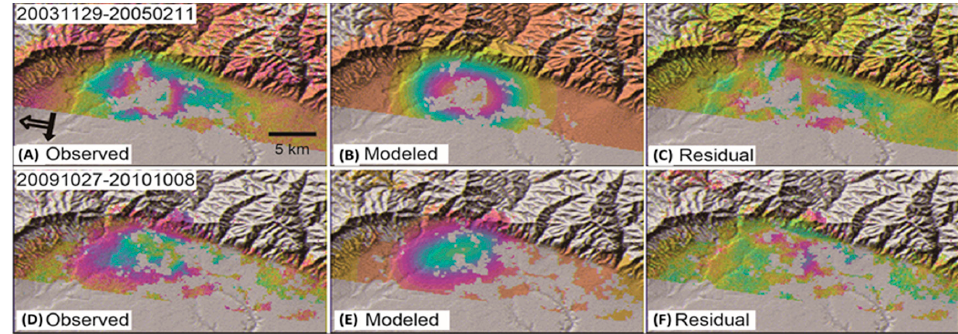
Figure 12. ( A – F ) Observed interferograms; synthetic interferograms for sill sources that best fit the individual interferograms; and residual interferograms, which are the differences between the observed ( left ) and the modeled ( middle ) interferograms. Table 1. Parameters for the best-fitting model sill (see text for details). Uncertainties correspond to 95% confidence.